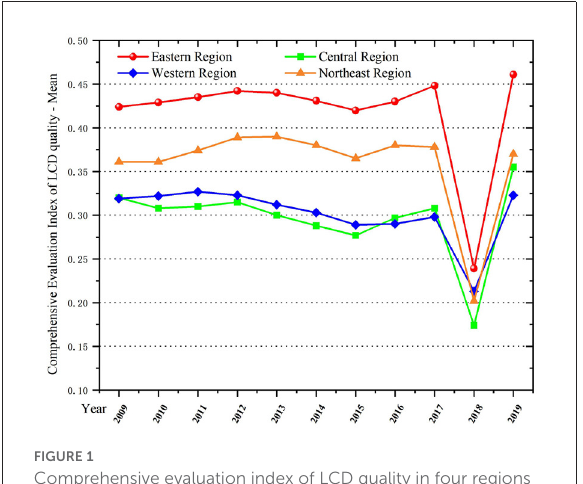
FIGURE1 Comprehensive evaluation index of LCD quality in four regions of China, 2009–2019.